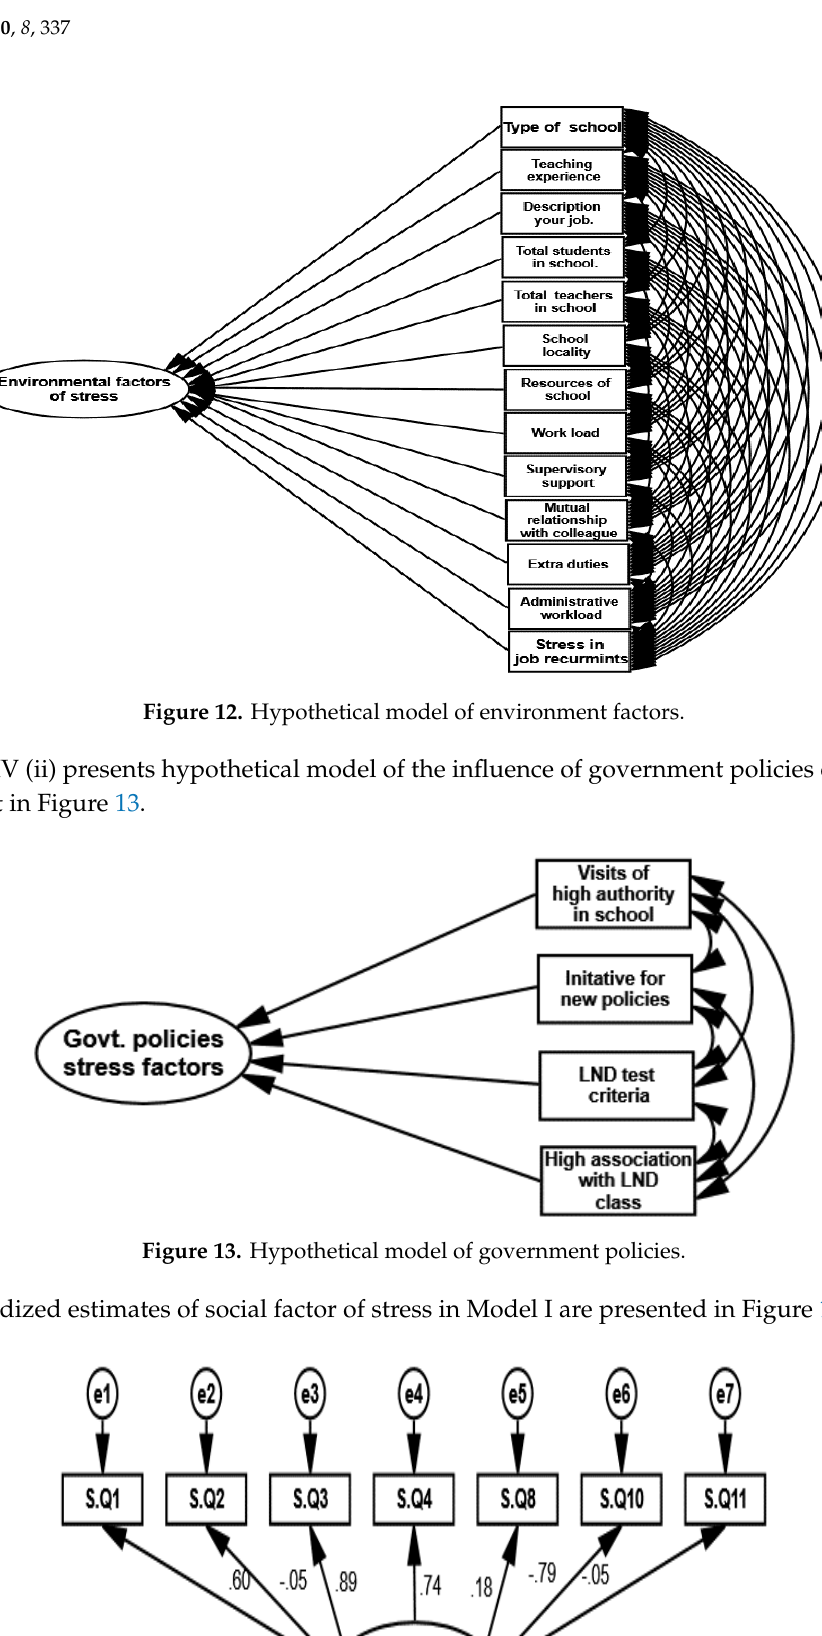
Figure 11. Hypothetical model of economic factors.